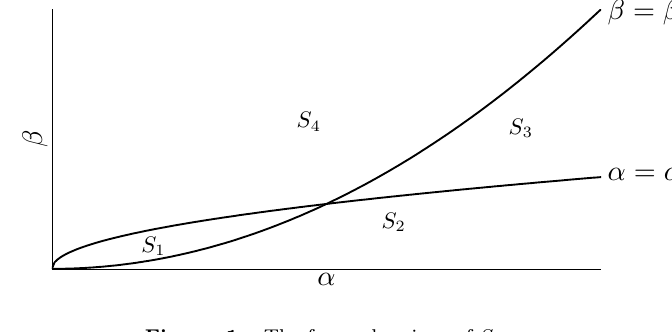
Figure 1. The four subregions of S